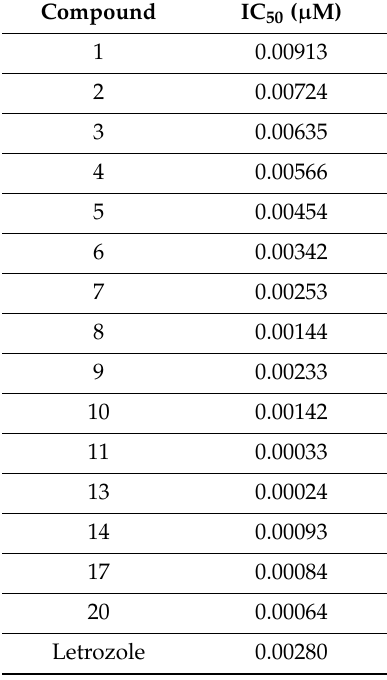
Table 2. Aromatase inhibitors’ activities of compounds 1–14 , 17 and 20